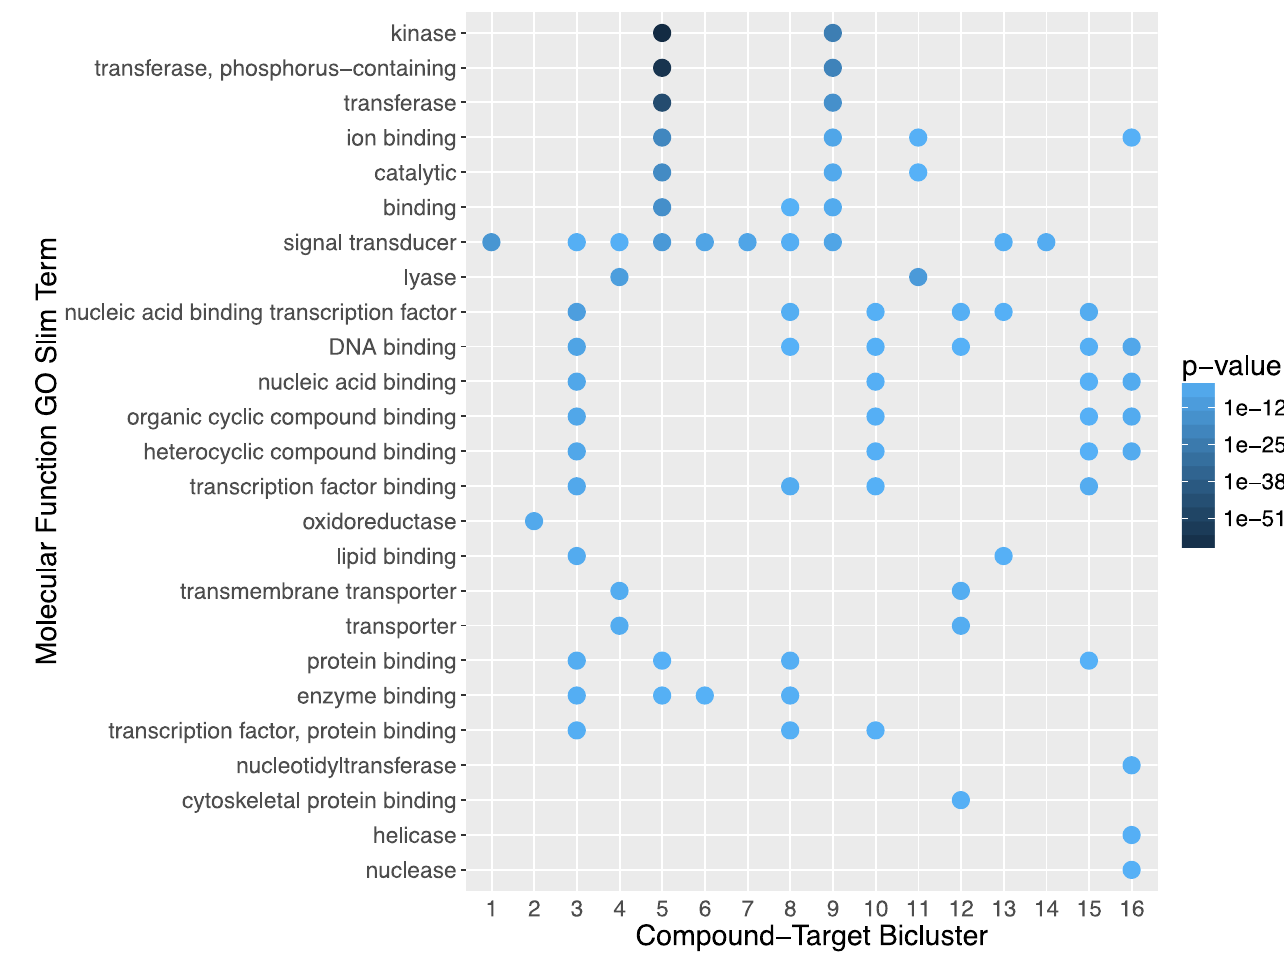
Fig 8. Molecular Function Gene Ontology Slim (MF GO Slim) term enrichment for each drug-target bicluster. Enrichment measuredby hypergeometric test. Terms with p (cid:20) 0.05 are shown and sorted increasingly.